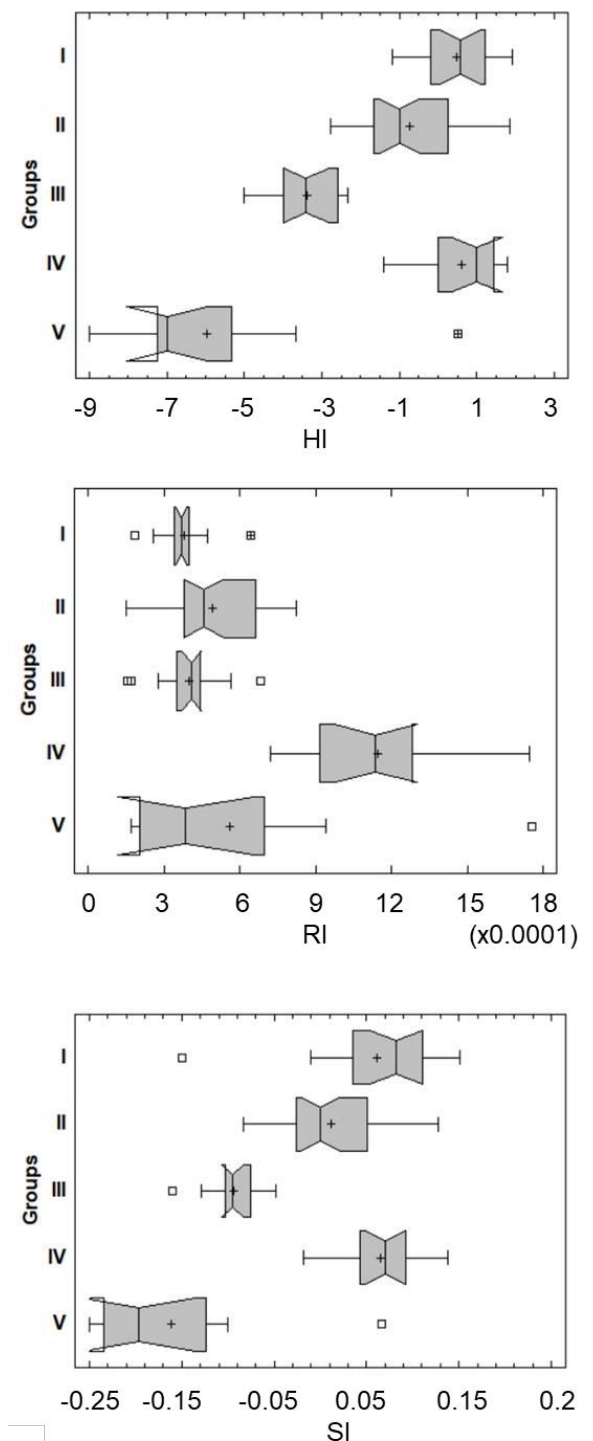
Figure 3. Comparison of medians of color indices (HI, RI, SI) by groups of road dust. I, GB, greyish brown; II, G, gray; III, DG, dark gray; IV, DGB, dark grayish brown; and V, VDG, very dark gray.